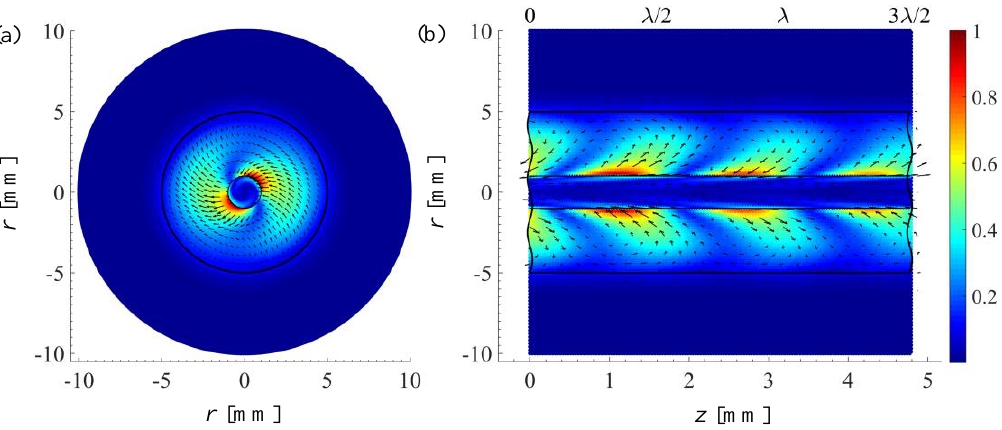
Figure 7. Electric field distributions of the fundamental “tube” mode in the transverse ( a ) and longitudinal ( b ) cross-sections of the waveguide filled with blood plasma at a frequency of 50 GHz.